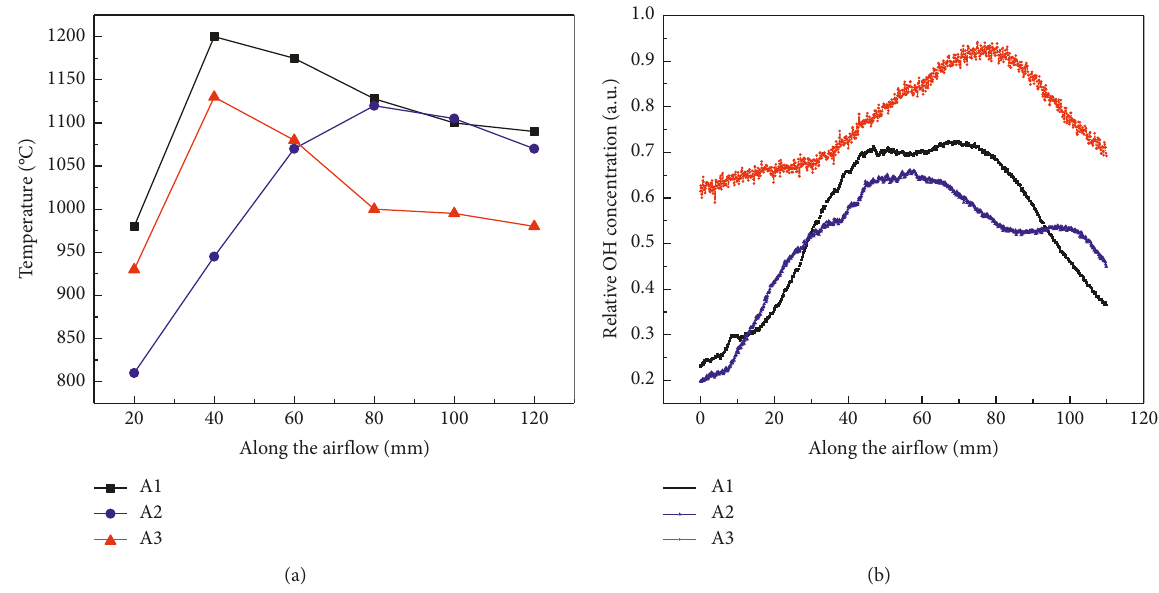
Figure 5: (a) Temperature distributions across the central axis; (b) distribution of relative OH concentration along the